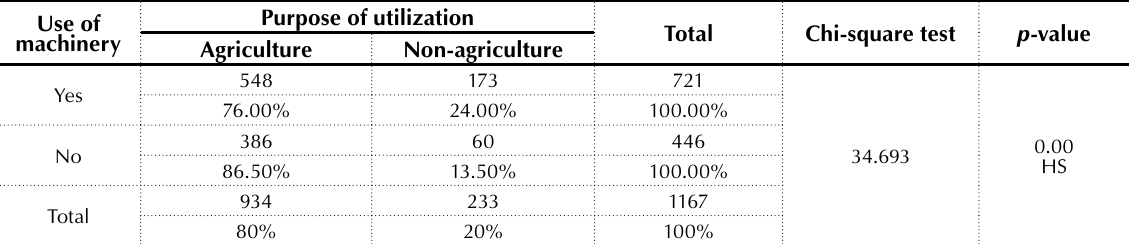
Source: Primary data.